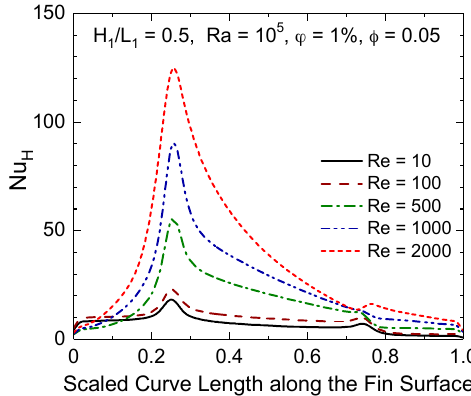
Figure 10. Variations of local Nusselt numbers with Reynolds numbers for a fixed fin aspect ratio ( H 1 / L 1 = 0.5).